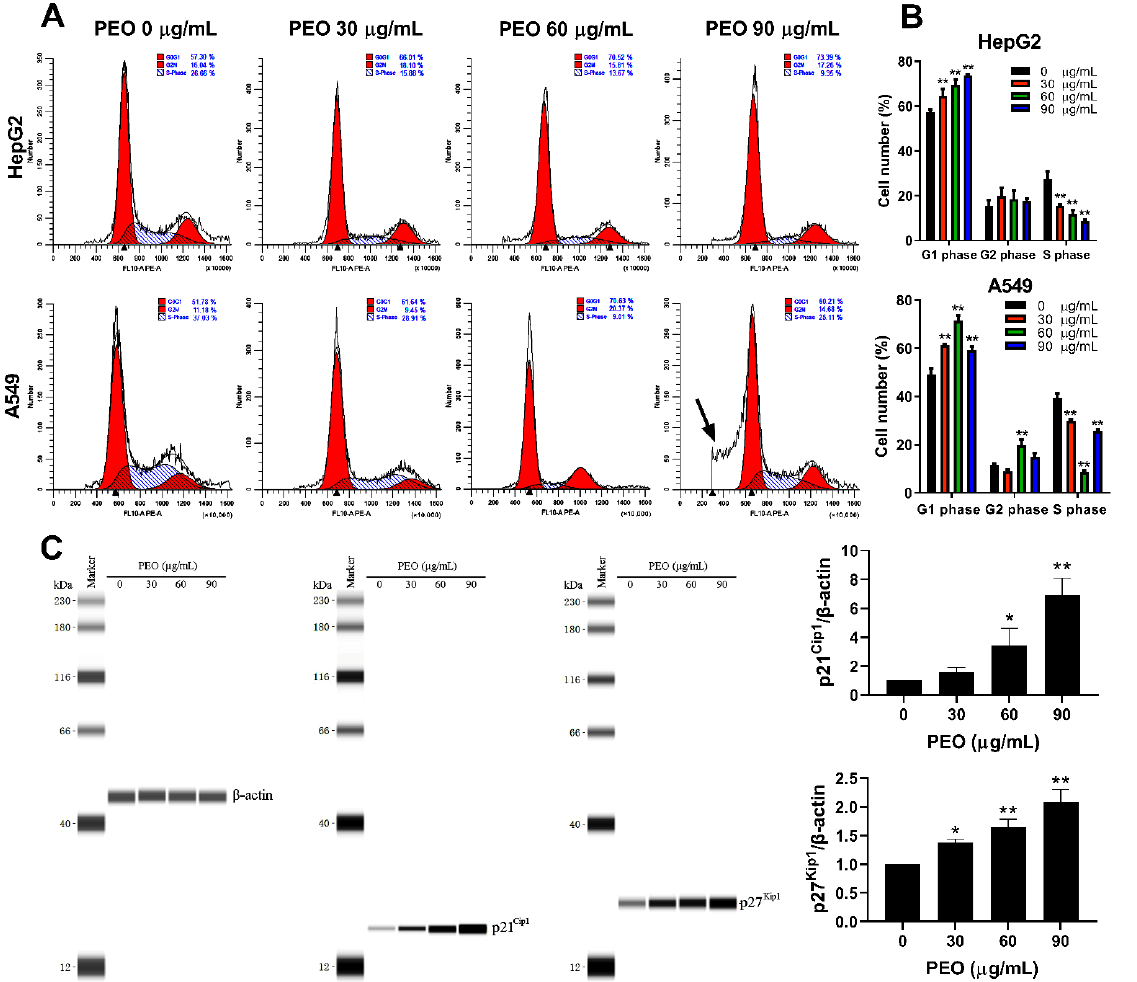
Figure 6. Cell cycle analysis of HepG2 and A549 cells treated with PEO. ( A ) HepG2 and A549 cells were treated with or without PEO (30, 60, and 90 µg/mL) for 24 h, and then cells were collected and fixed overnight. Cells were centrifugated and resuspended in PBS with PI/RNase Staining Buffer for 30 min. The cell cycle distributions were analyzed on a Cytoflex S flow cytometer. ( B ) Percentage of first gap (G1), synthesis (S), second gap (G2) phase cells in the total cells. ( C ) Expression levels of p21 Cip1 and p27 Kip1 in A549 cells treated with PEO as detected by western blot. The values represent mean ± standard deviation of three independent experiments. * p < 0.05, ** p < 0.01 compared with the untreated group. The black arrow indicates cell debris.